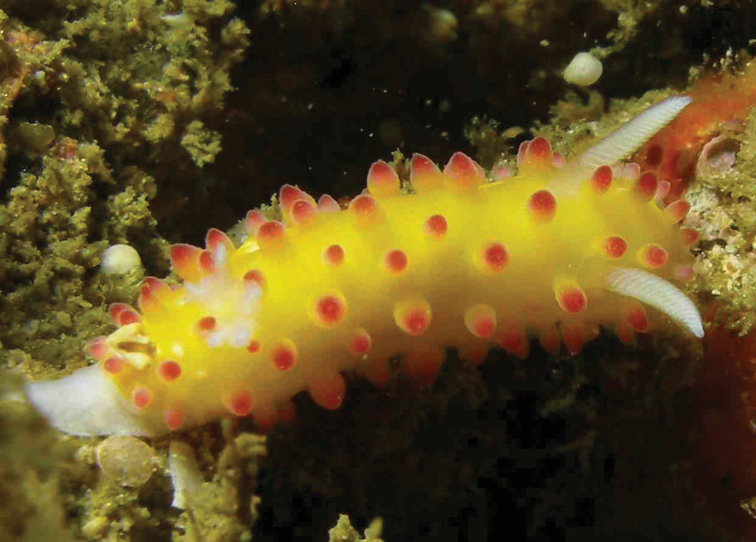
Cadlinella ornatissima, 13 mm pres., Sri Lanka, photo: S Kahlbrock.